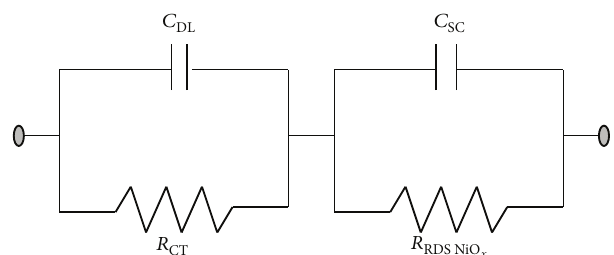
Figure 17: Proposed scheme of equivalent circuit for RDS NiO 𝑥 polarized at 2.3 V versus Li +